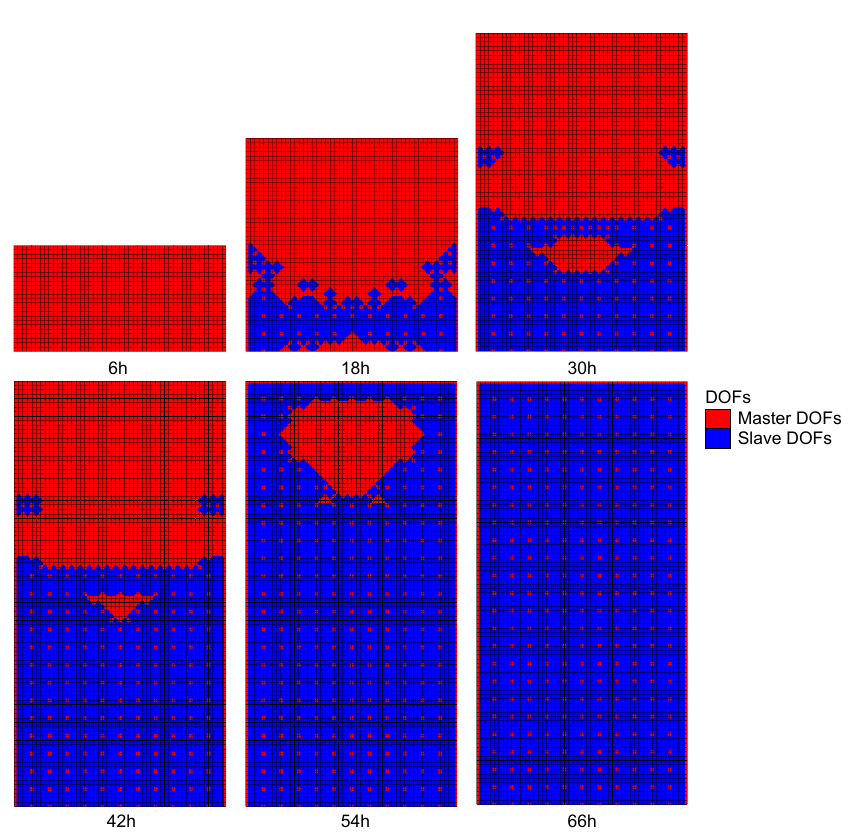
Figure 8. The distribution of DOFs of Example 2